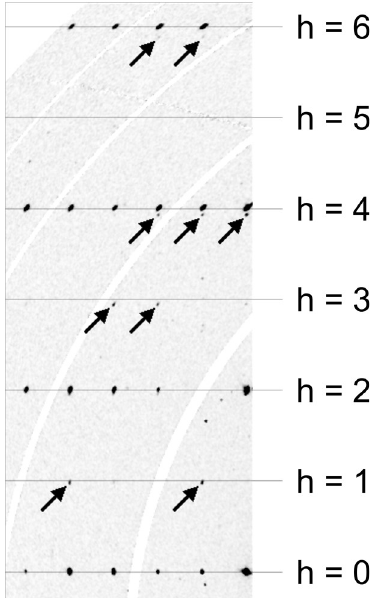
Figure 7. Reconstruction of the reciprocal space layer hk0 of a crystal affected by 90° rotation twinning. Arrows point to reflections belonging to the smaller twin individual. Synchrotron diffraction data. The curved white bands are caused by gaps between the elements of the Pilatus 2M-F detector and contain no measured data.